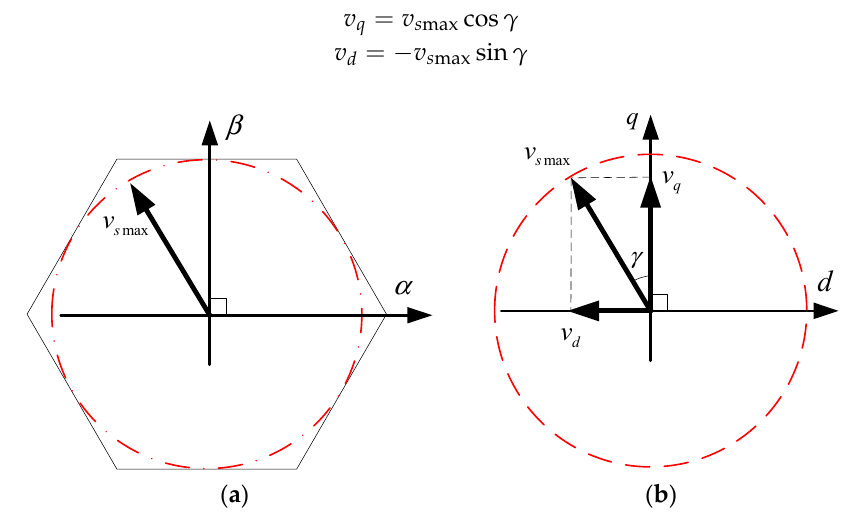
Figure 2. The vector diagram of permanent magnetic synchronous motors in the flux-weakening region. ( a ) The voltage hexagon in the stationary αβ frame; ( b ) The vector diagram in the synchronously rotating frame.